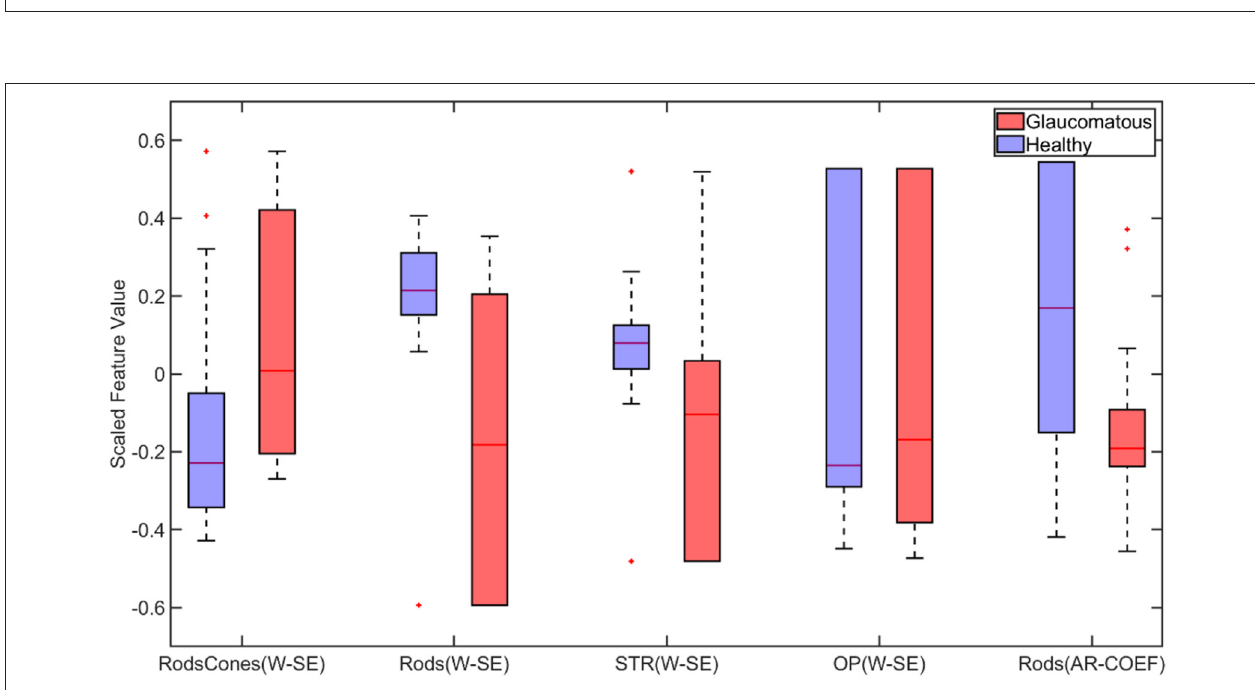
FIGURE 5 | Box plot of wavelet-based features selected by Minimum Redundancy and Maximum Relevance (MRMR) feature selection algorithm for binary classification (W-SE, Wavelet based Shannon Entropy; AR-COEF, Autoregressive Coefficient). On each box, the central mark indicates the median, and the bottom and top edges of the box indicate the 25th and 75th percentiles, respectively. The whiskers extend to the most extreme data points not considered outliers, and the outliers are plotted individually using the “+” marker symbol.